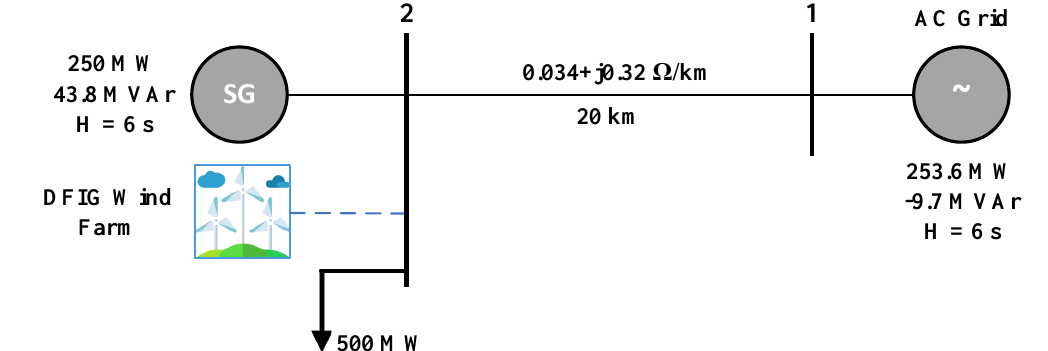
Figure A2. Two (2) bus system network model.